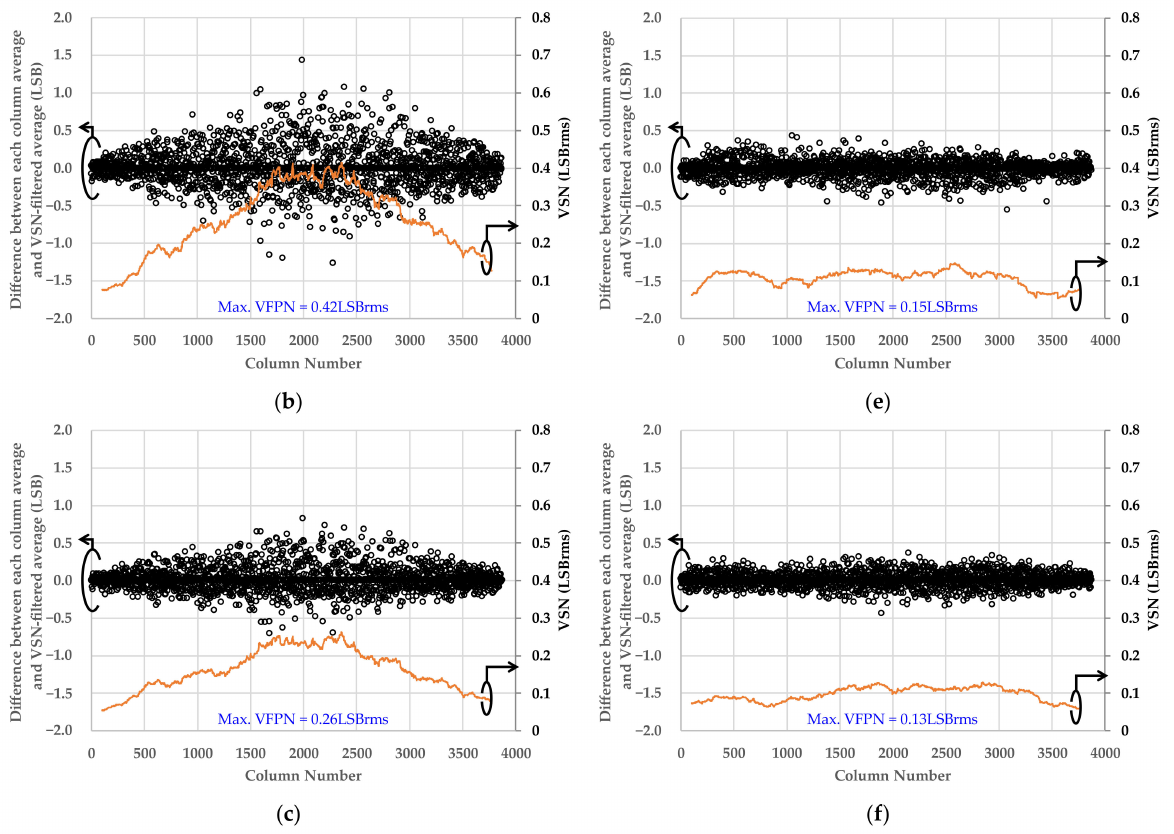
Figure 19. ( a – c ) show the VSN under the low-light condition calculated from images in Figure 18a–c taken with the conventional circuit. The operating voltages are as follows: ( a ) Typical operating voltage, ( b ) minimum operating voltage, and ( c ) maximum operating voltage, respectively. ( d – f ) show the VSN under the low-light condition calculated from the Figure 18d–f taken by the proposed circuit. The operating voltages are as follows: ( d ) typical operating voltage, ( e ) minimum operating voltage, and ( f ) maximum operating voltage, respectively. All graph data are values of digital gain ×